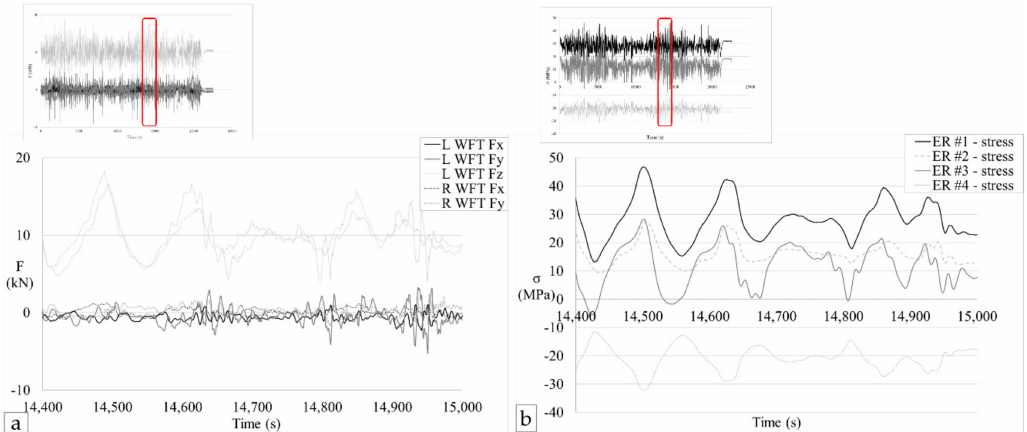
Figure 11. Time frame of load at wheel ( a ) and strain gauge outputs ( b ) for the rough terrain